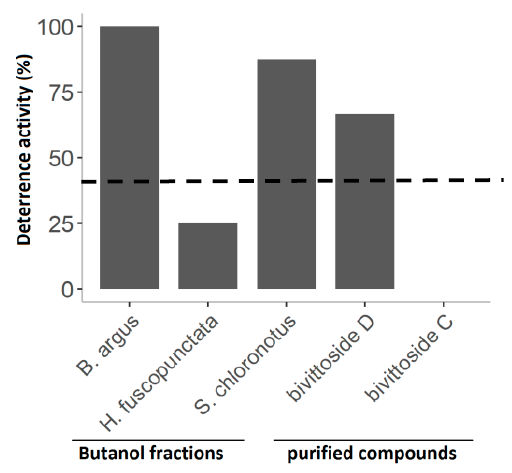
Figure 10. Percent deterrent activity of the butanol fractions from the three most active sea cucumber extracts, as well as two purified compounds (i.e., bivittoside D and bivittoside C ) from B. argus . The line at 40% indicates significant deterrence ( p < 0.05 , Fisher’s exact test, 1-tailed).